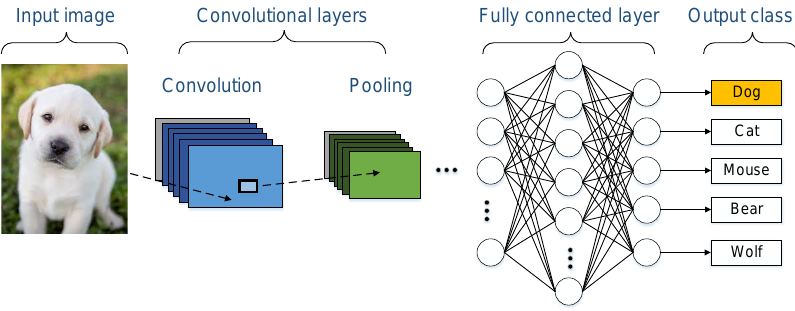
Figure 2. Demonstration of a Convolutional Neural Network (CNN) comprising an input image, convolution and pooling layers, fully connected layer, and output